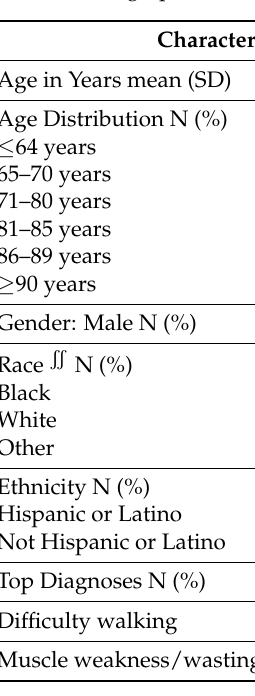
Table 1. Demographic, Braden Scale, and Movement Feature Characteristics (N =